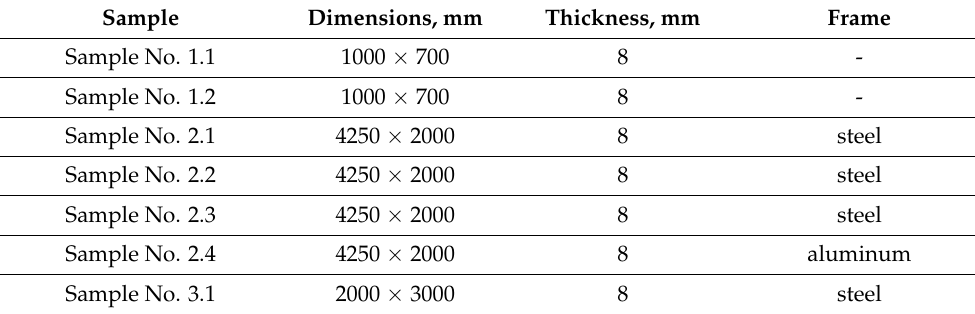
Table 1. Characteristics of the considered samples.